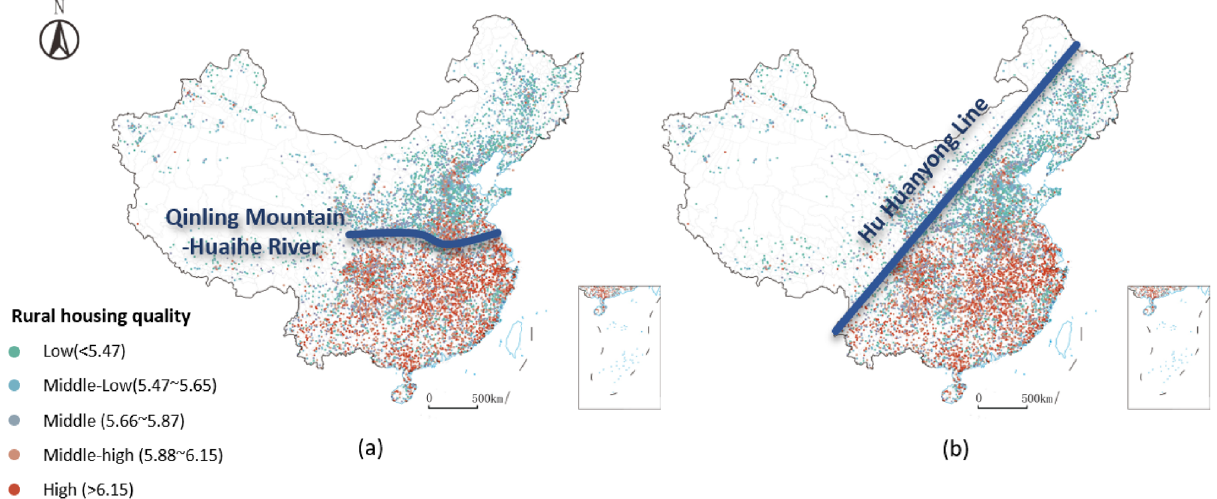
Figure 4. Two nationwide dividing lines for spatial pattern of housing quality in China. The map is created by Arcgis 10.0, and the base map is provided by Standard Map Service System (http:// bzdt. ch. mnr. gov.